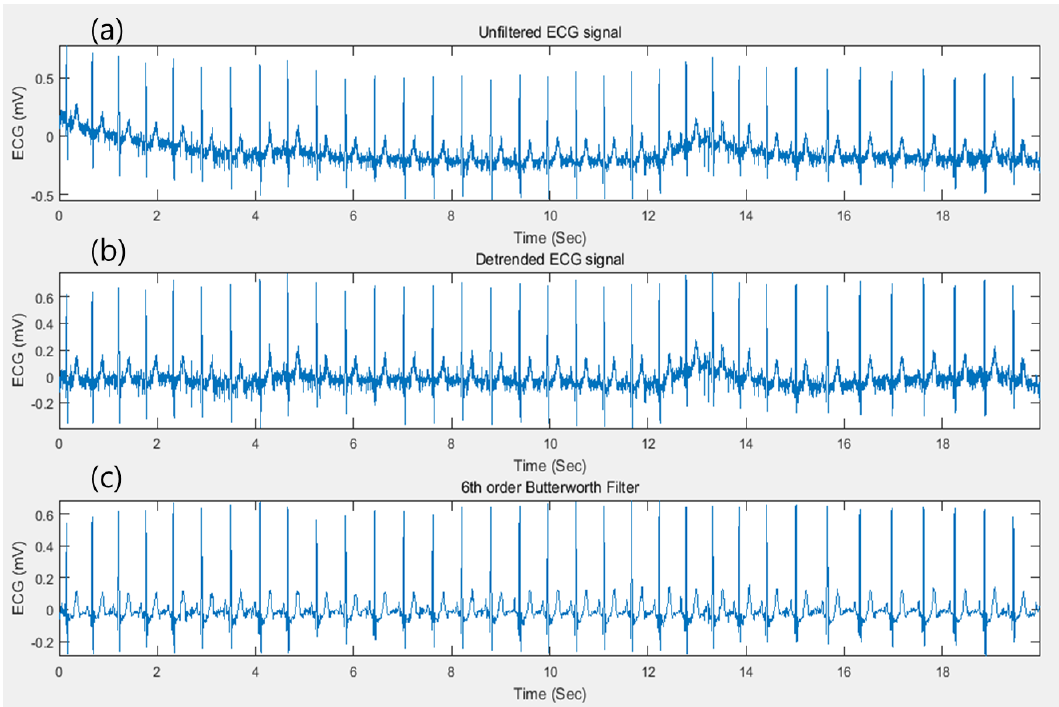
Figure 5. ( a ) A raw ECG signal with non-linear trend. ( b ) Detrended ECG signal. ( c ) Filtered ECG signal by applying 6th order Butterworth